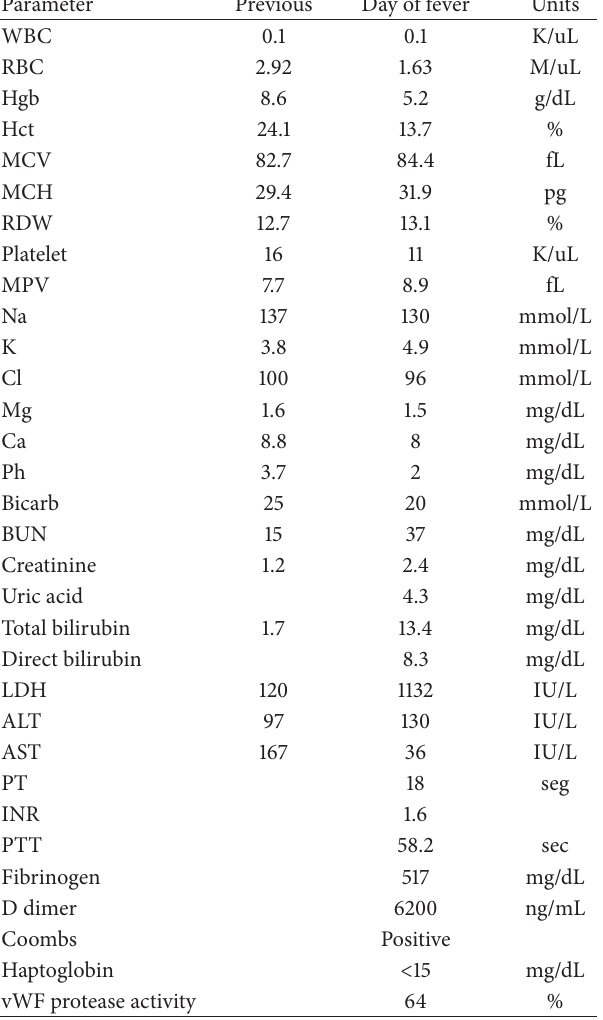
Table 1: Laboratory